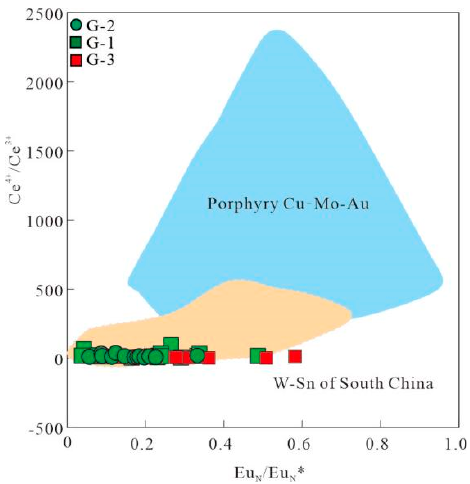
Figure 18. The Ce 4+ /Ce 3+ versus Eu N /Eu N * diagram. The data of blue field named Porphyry Cu-Mo-Au are from [49,70] and there in, the orange field are from [74]. Blevin [75] carried out important work on the granite in the Lachlan fold belt and proposed the parameters to estimate the redox state of granite [75]: